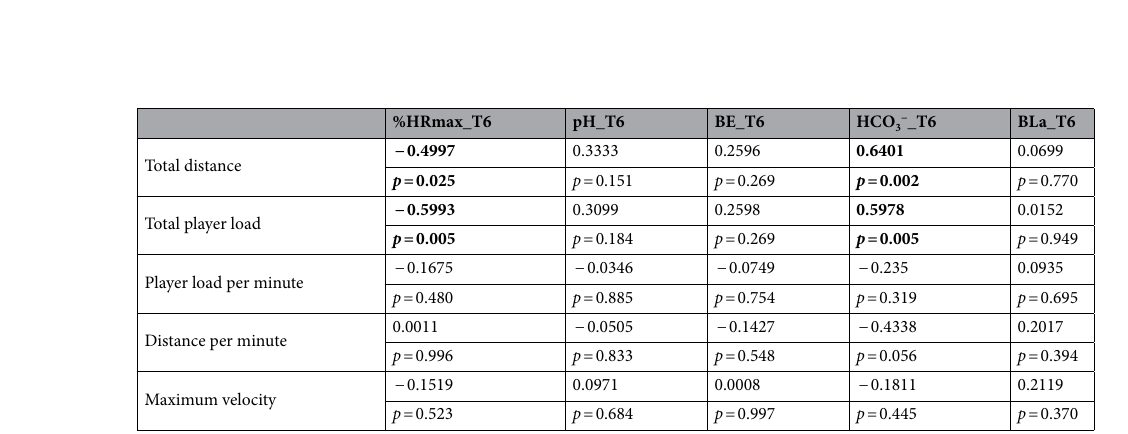
Table 5. Correlation between the average values of ETL indicators from all six SSGs and the values of ITL markers measured after the sixth game. SSGs—small-sided games; BLa—blood lactate; pH—blood pH; BE— base excess; HCO 3 − —blood bicarbonate; %HRmax—percentage of maximum heart rate. Significant values are in